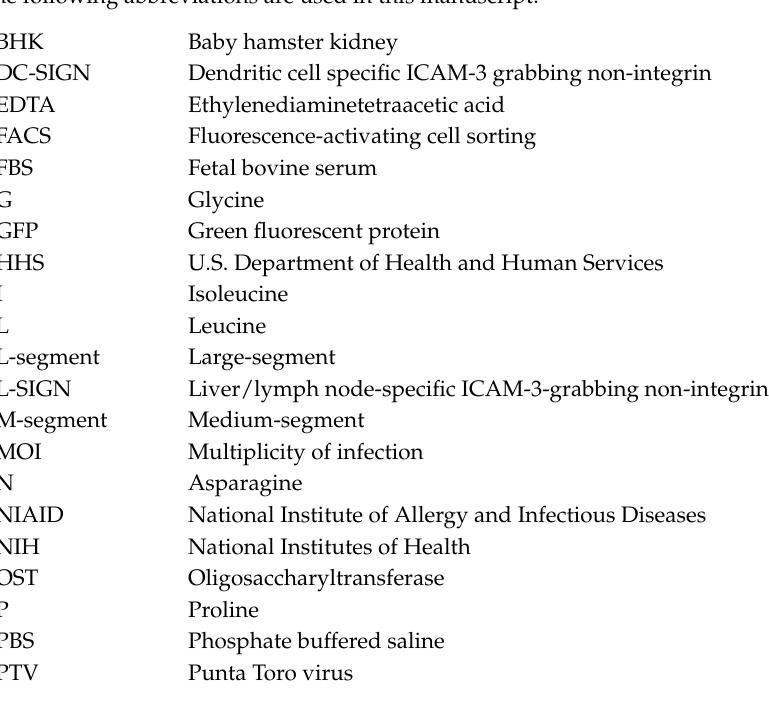
Figure S1: Co-expression of GFP and DC-SIGN in Jurkat-DC-SIGN cells, Figure S2: Populations of